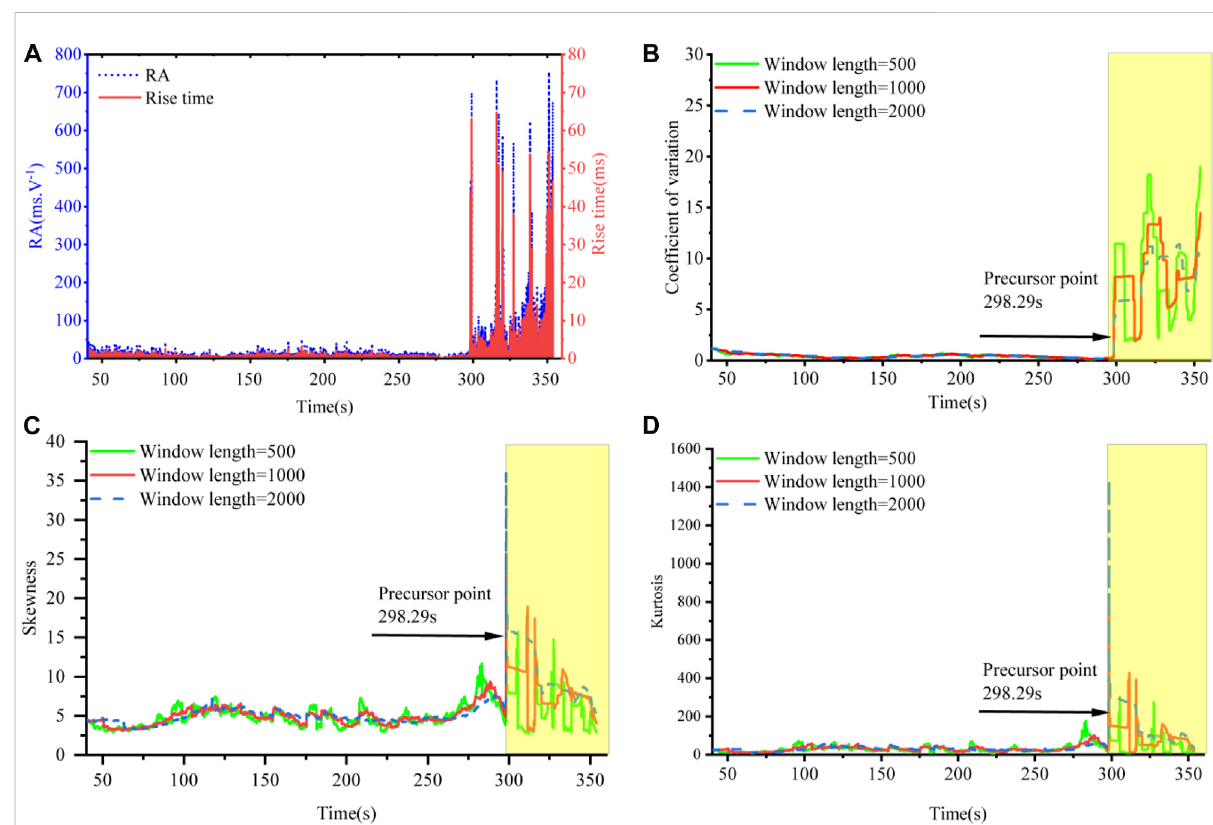
FIGURE 4 Acoustic emission parameters and the effect of window length on the metrics of the critical slowing down (CSD) phenomenon in w1. (A) rise time and RA ofacoustic emission, (B) effect of window length on thecoef fi cient ofvariation, (C) effect ofwindowlength onskewness, and (D) effect of window length on